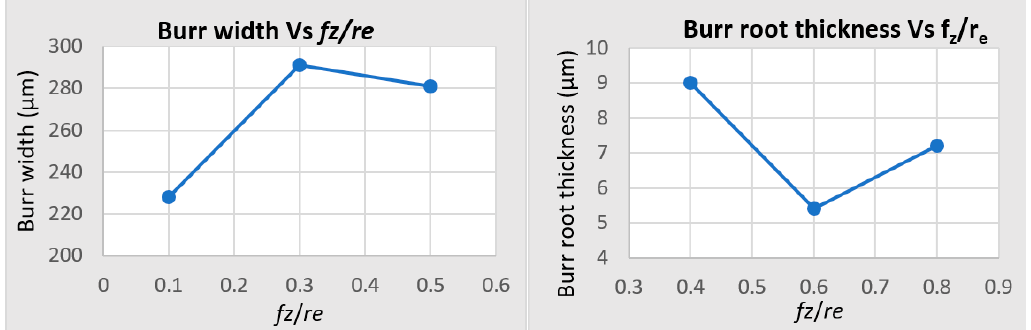
Figure 7. Main effect plot for f z/ r e vs. burr width [81] (with the permission of Elsevier).